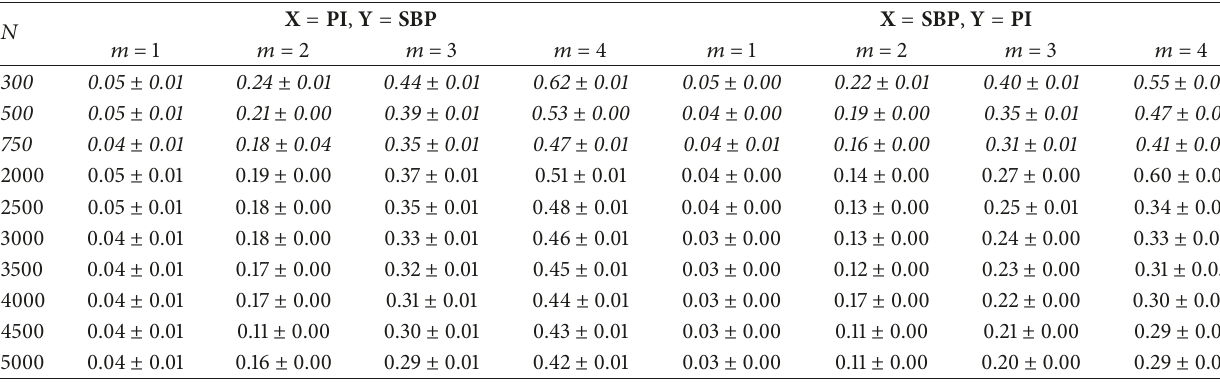
Table 4: Threshold values obtained from real signals.